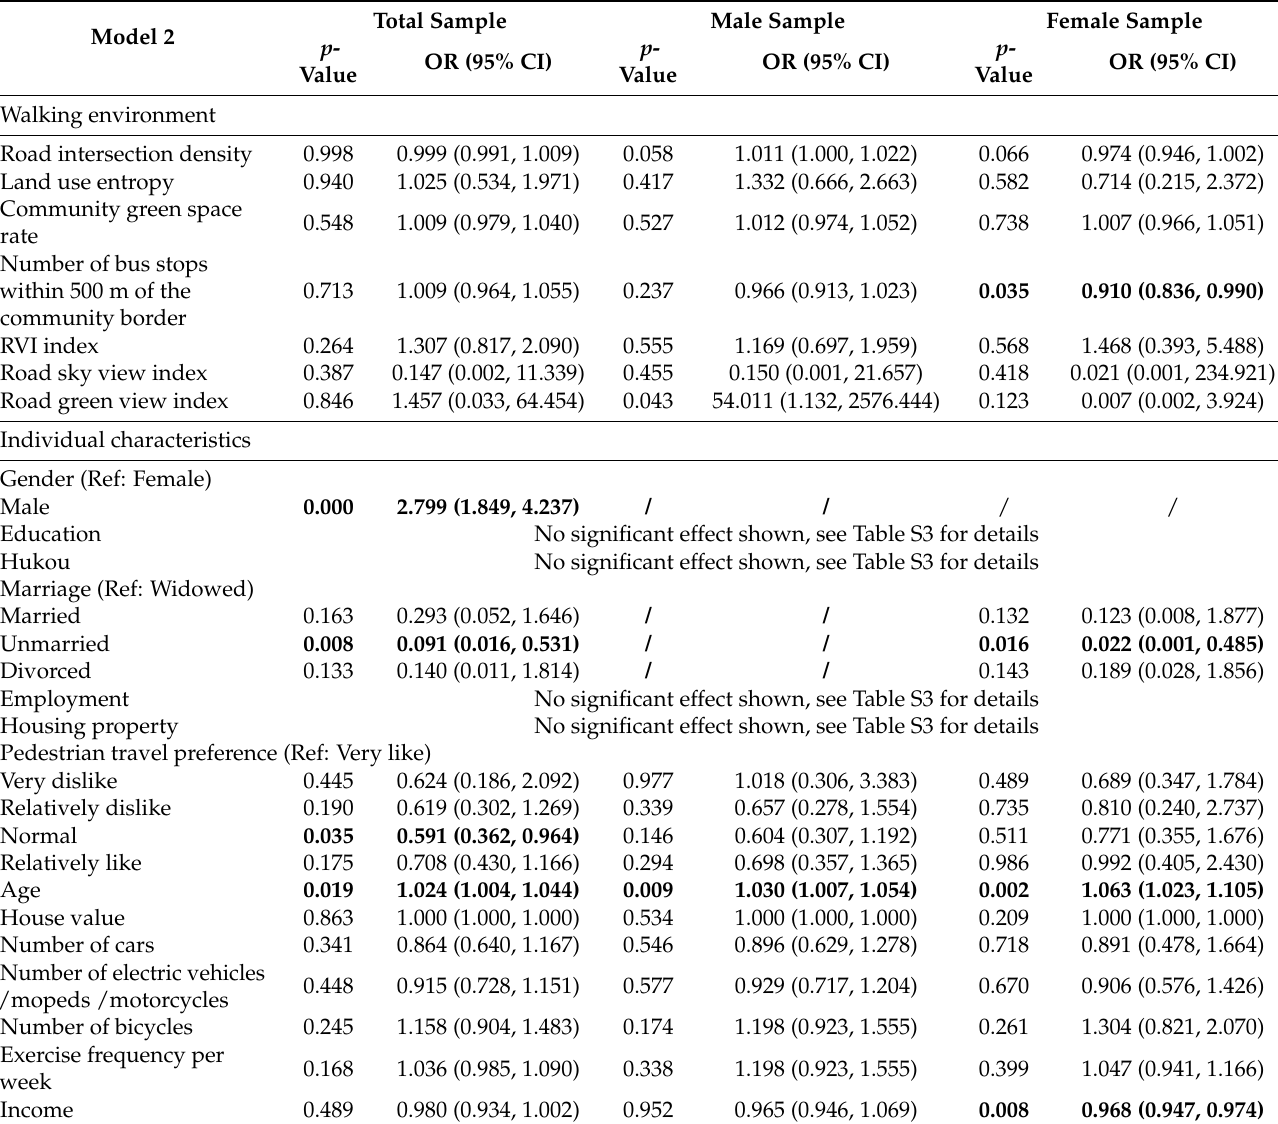
Table 3. Generalized linear estimation equations testing for the risk of obesity among residents based on walking